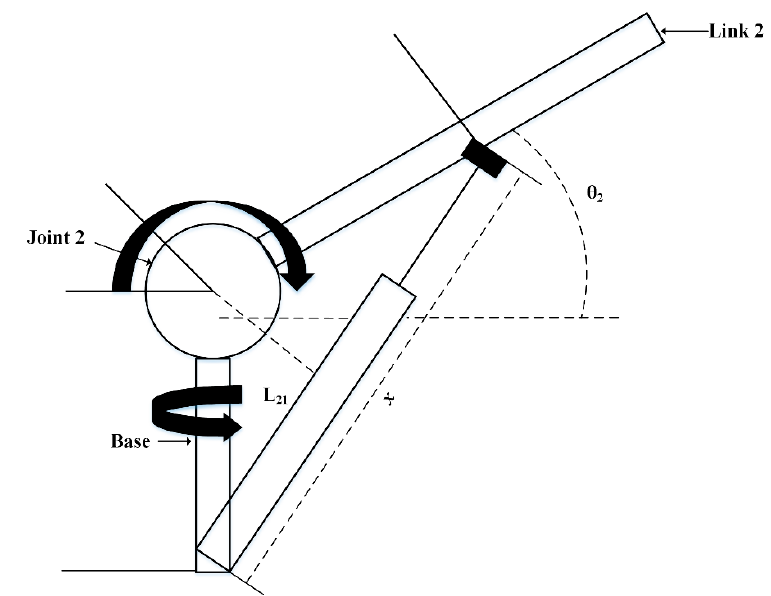
Figure 3. Schematic diagram of end effector.